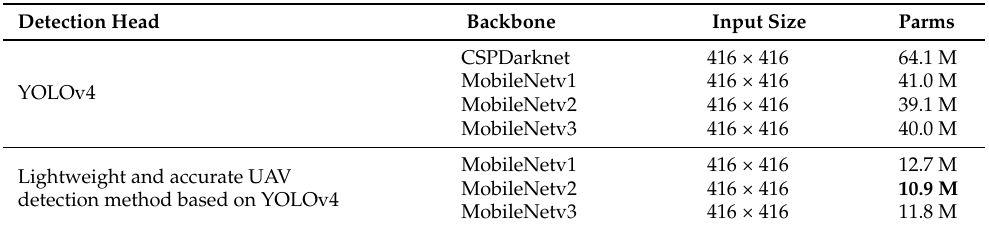
Table 4. Comparison of experimental results with Mobienet series as backbone